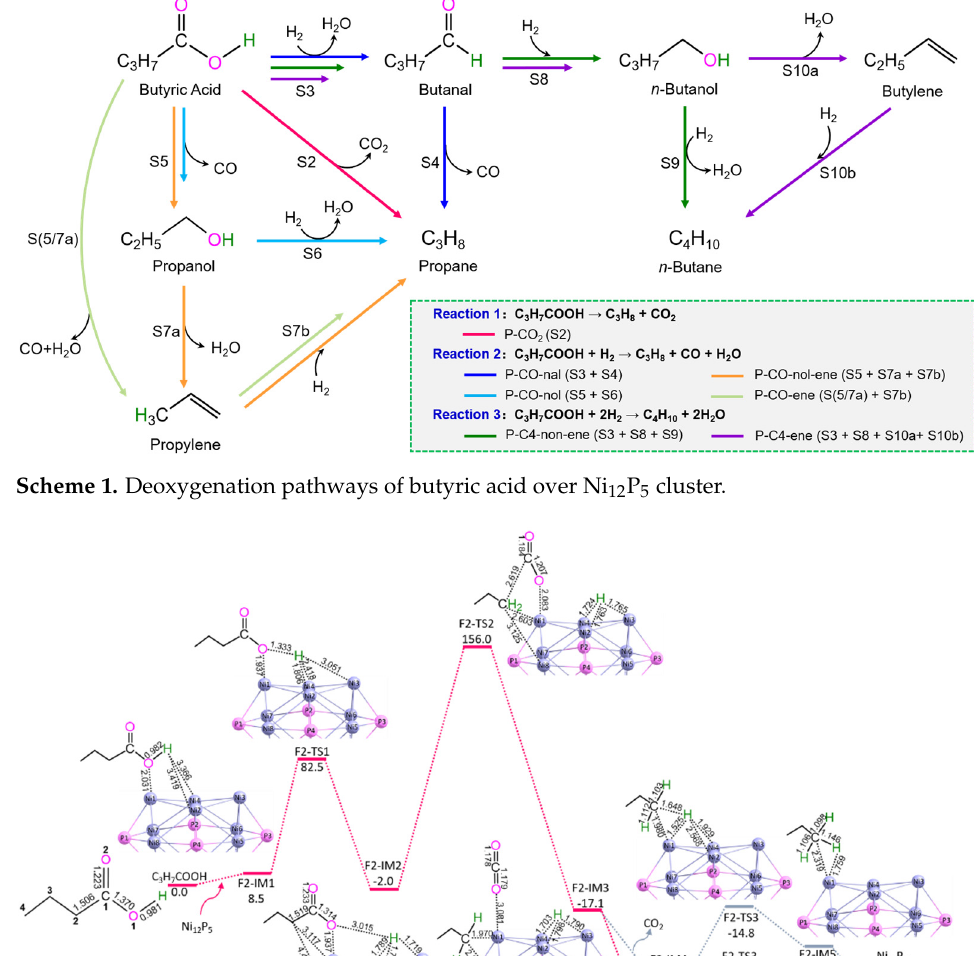
Figure 2. The potential energy curves with the relative Gibbs free energy ( G r , kJ mol − 1 ) and the geo- metric structures with bond lengths (Å) for reaction stage S2 over Ni 12 P 5 cluster at GGA − PBE/DSPP, DNP level. For brevity, some hydrogen atoms are hidden. CO 2 ↑ shows the CO 2 pressure with 10 − 5 atm under experimental condition.